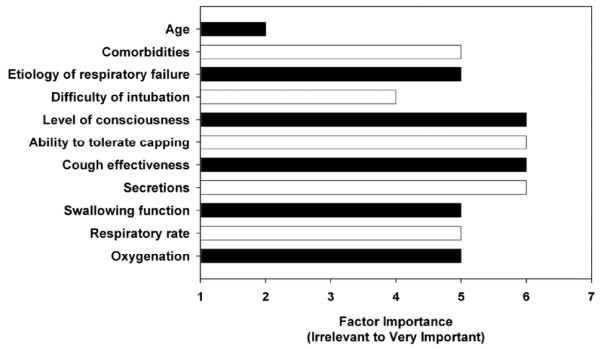
Ratings of determinants of tracheostomy decannulation. Data are expressed as median values.